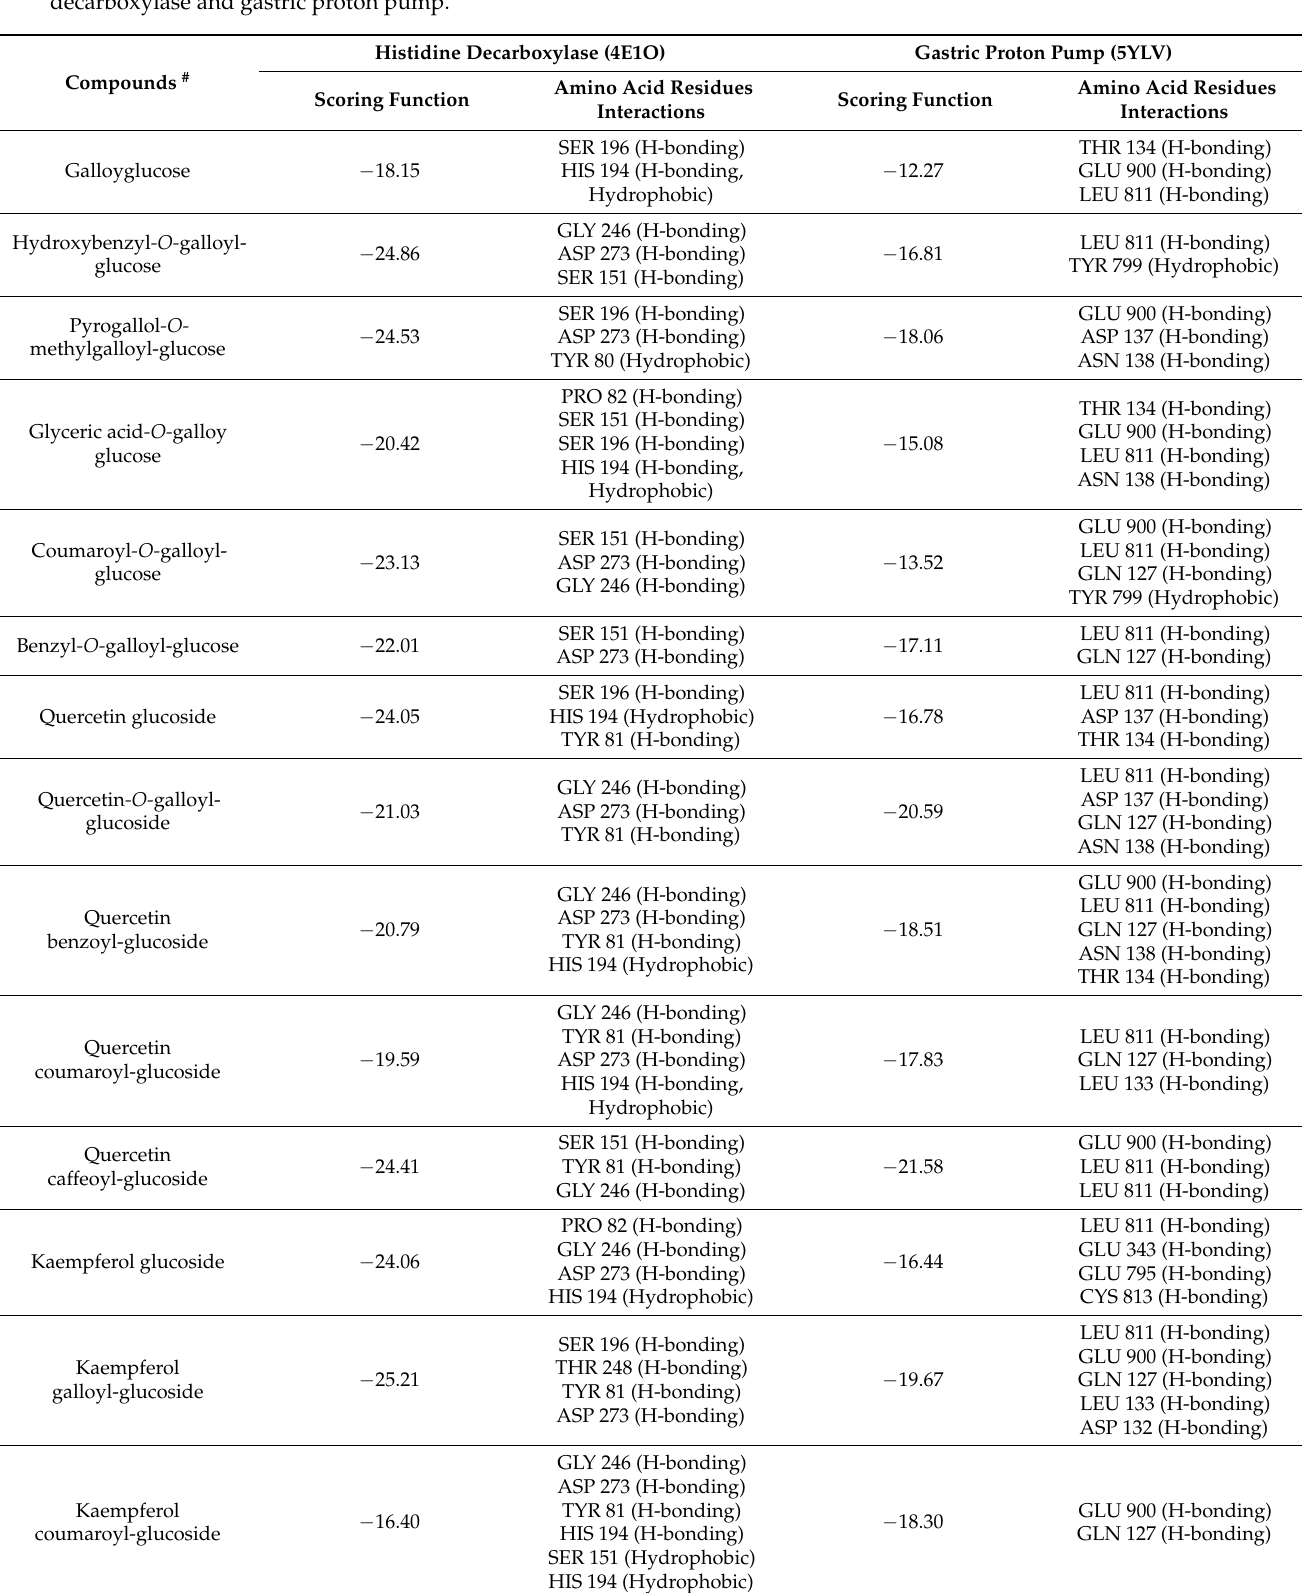
Table 2. Scoring functions and amino acid interactions for the phytoconstituents from A. anthelmintica docked to histidine decarboxylase and gastric proton